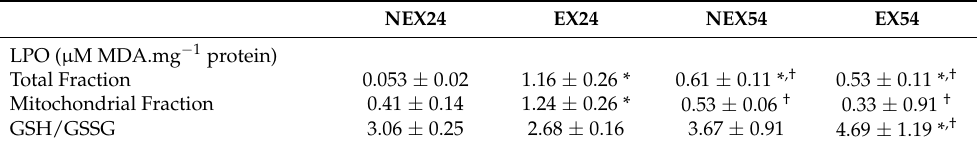
Table 4. Oxidative stress markers: lipid peroxidation (LPO) and ratio GSH and